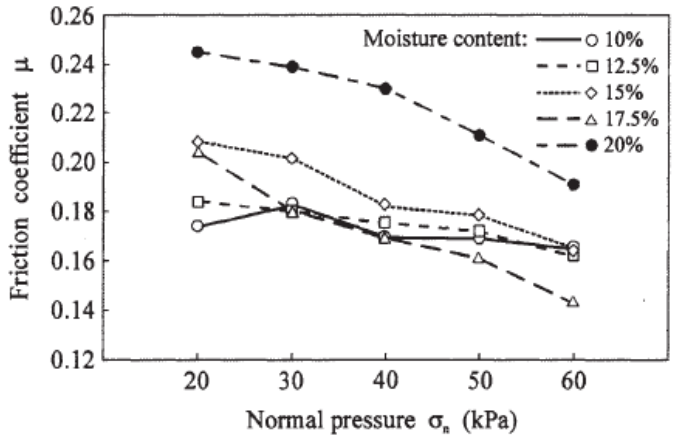
Figure 1. Relationship between the moisture content and the coefficient of internal friction for wheat grain bulk [49].